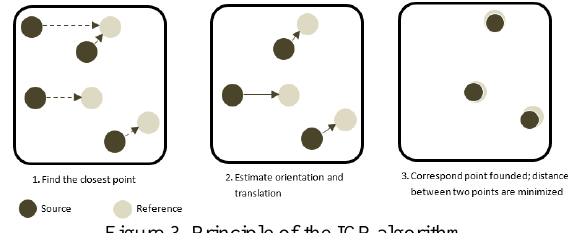
Figure 3. Principle of the ICP algorithm.